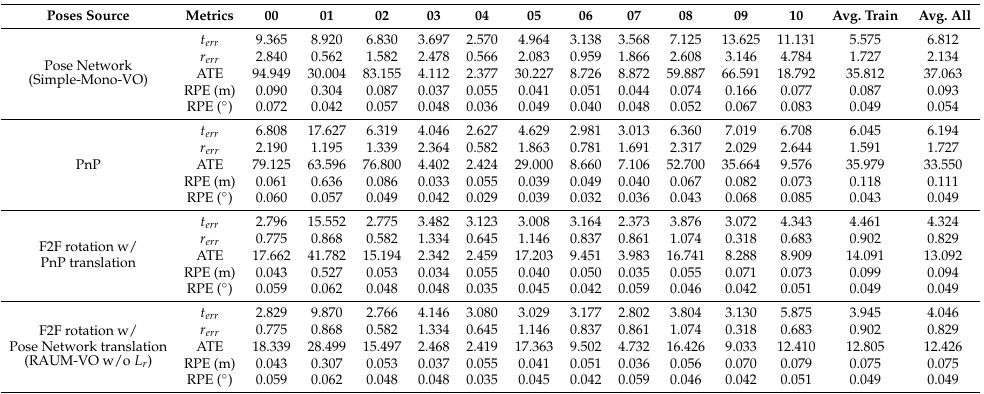
Table 4. PnP vs. pose network. Comparison of the trajectory estimated by PnP combined with the depth network and the poses predicted by our trained